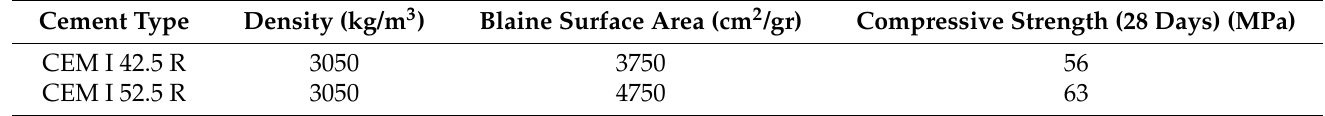
Table 3. Properties of cements.